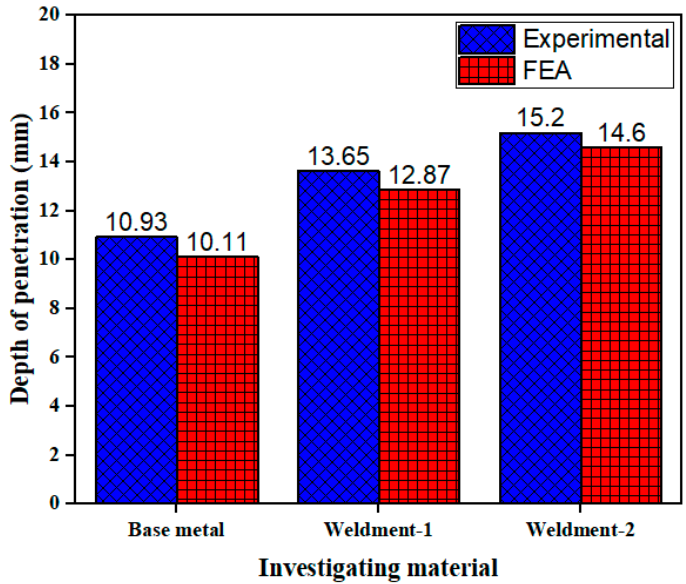
Figure 6. Experimental vs. FEA.